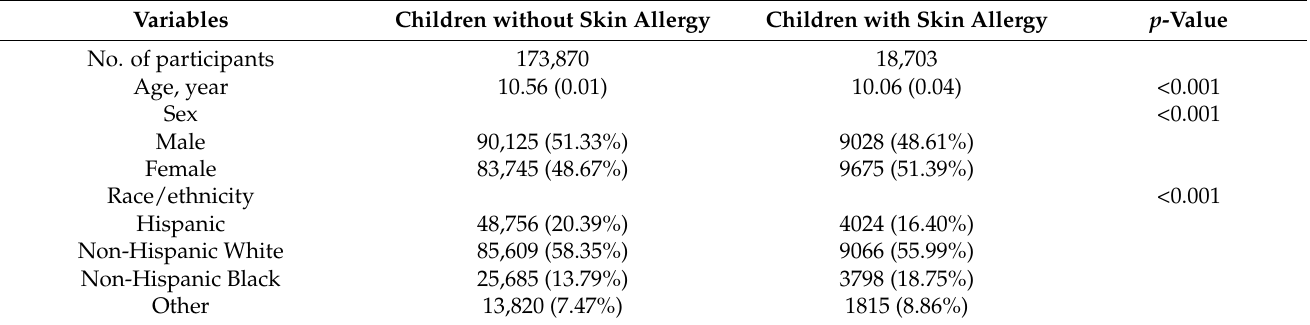
Table 3. Characteristics of the participants ( n = 192,573) by skin allergy